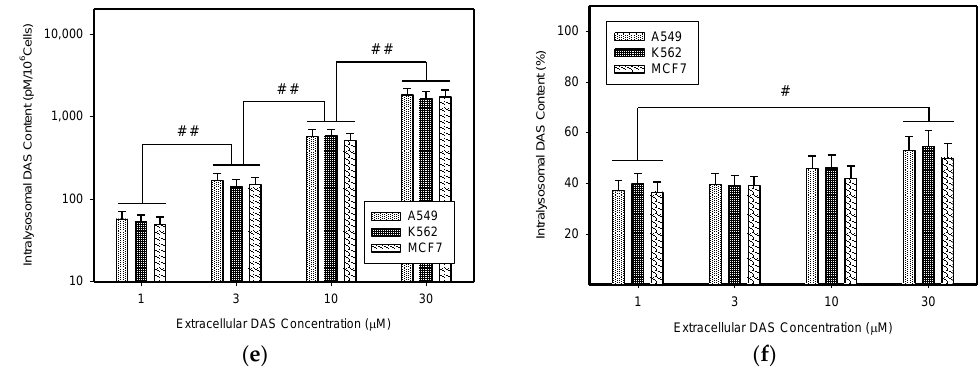
Figure 6. Accumulation of TKIs in the lysosomes of SUN-stimulated cancer cells. Cells were cultured for 3 days in the presence of 1 µM SUN under standard conditions. Cells cultured in medium without SUN were taken as controls. ( a ) Accumulation of IM (absolute value). ( b ) Accumulation of IM (relative value). ( c ) Accumulation of NIL (absolute value). ND — not determined (due to limited NIL solubility). ( d ) Accumulation of NIL (relative value). ( e ) Accumulation of DAS (absolute value). ( f ) Accumulation of DAS (relative value). Columns represent the means and standard deviations of four independent experiments. * denotes a significant change in the intralysosomal IM content ( p < 0.05) between the indicated cell lines. # denotes a significant change in the intralysosomal content of appropriate TKI ( p < 0.05) between the groups indicated. ## denotes very significant change in the intralysosomal content of appropriate TKI ( p < 0.01) between the groups indicated. Biomolecules 2019 , 9 , x FOR PEER REVIEW